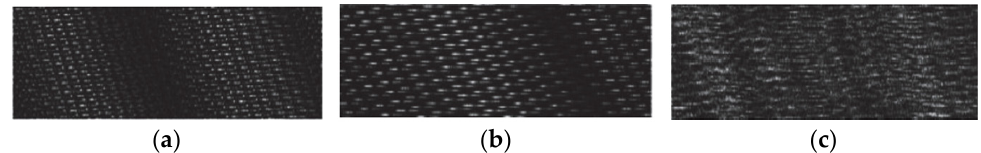
Figure 6. Examples of the generated vibration image using signal rectification and LBP techniques for ( a ) bearing inner race fault, ( b ) bearing outer race fault, and ( c ) bearing ball fault [51].